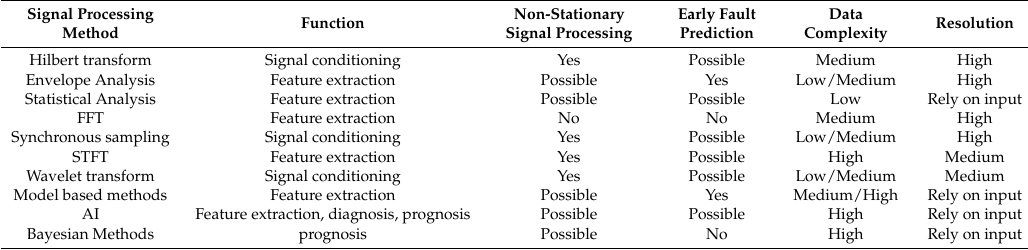
Table 3. Comparison of different signal processing methods for WT condition